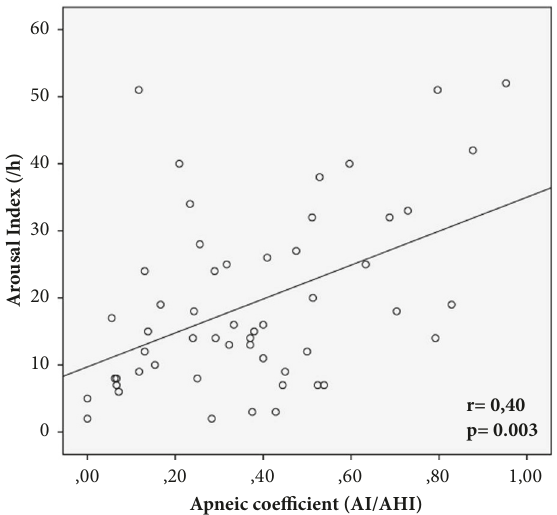
Figure 2: Correlation between arousal index and apneic